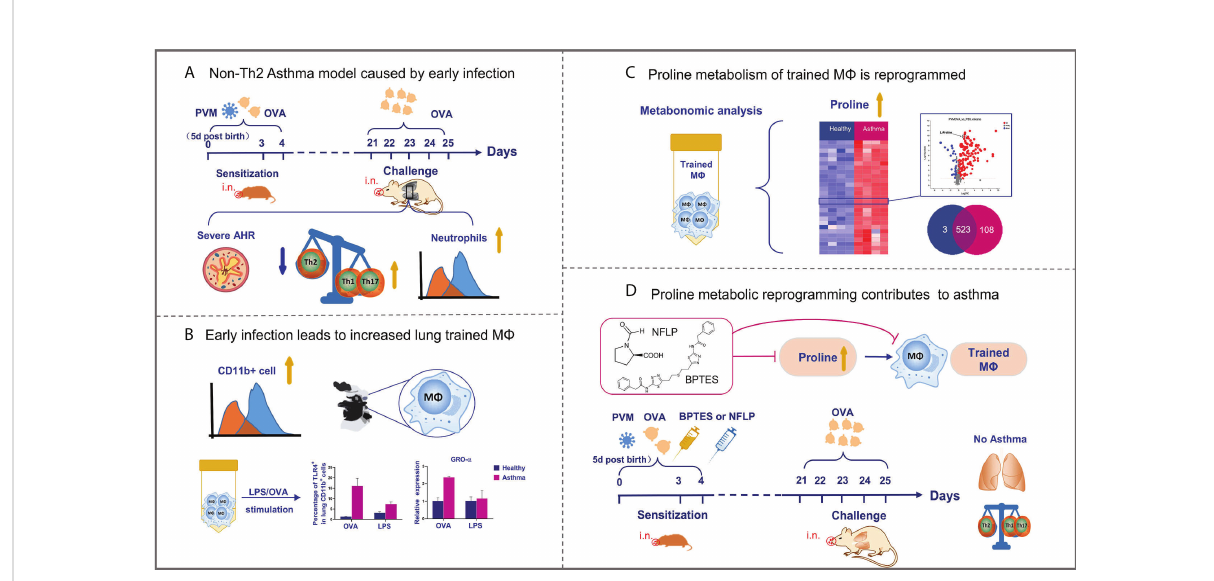
FIGURE 7 Graphical representation of results. (A, B) Neonatal respiratory virus infection can promote the occurrence of non-Th2 allergic asthma through the production of a large number of trained macrophages, which undergo metabolic reprogramming. (C, D) Notably, proline metabolic reprogramming mediate development of the trained macrophages as well as non-Th2 allergic asthma in childhood